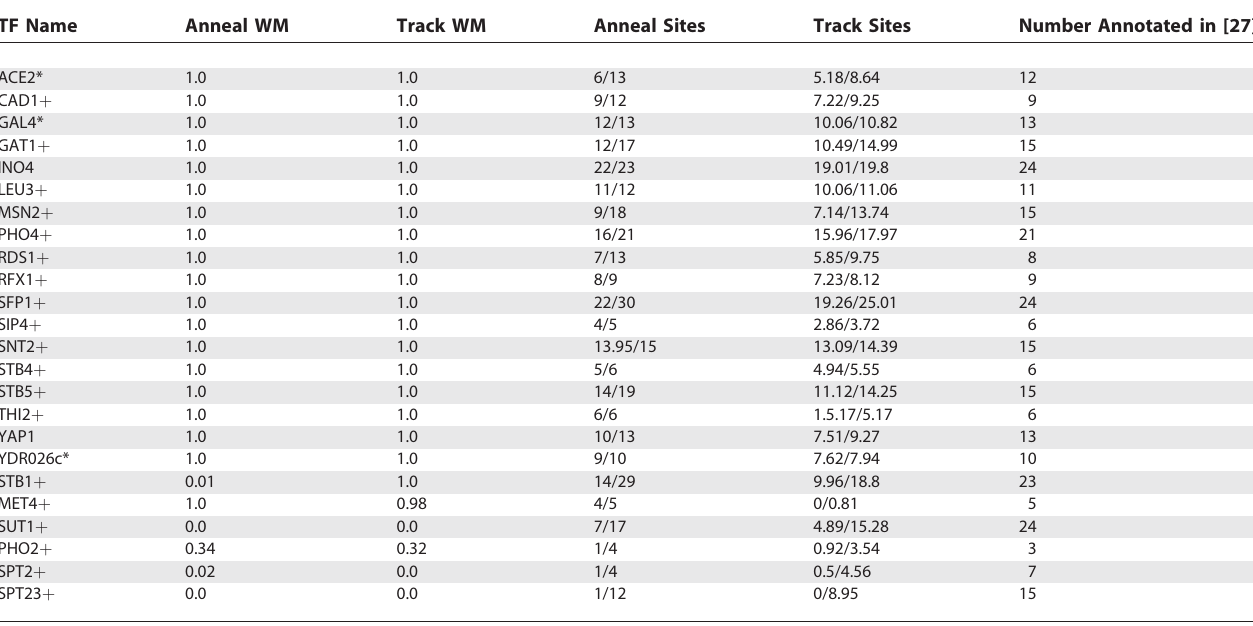
Table 2. Results of PhyloGibbs on Collections of Intergenic Regions for 24 TFs for Which the Motif-Finding Algorithms in [27] Found a Significant